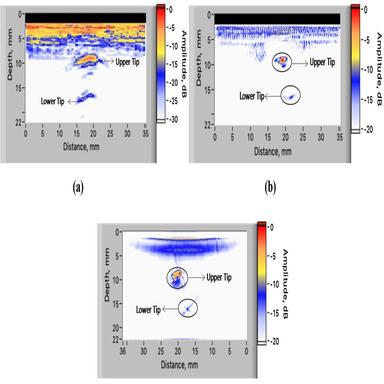
B-scan images for 16 inclined slot (a) Raw PA-SAFT (b) Processed PA-SAFT and (c) FMC + TFM.